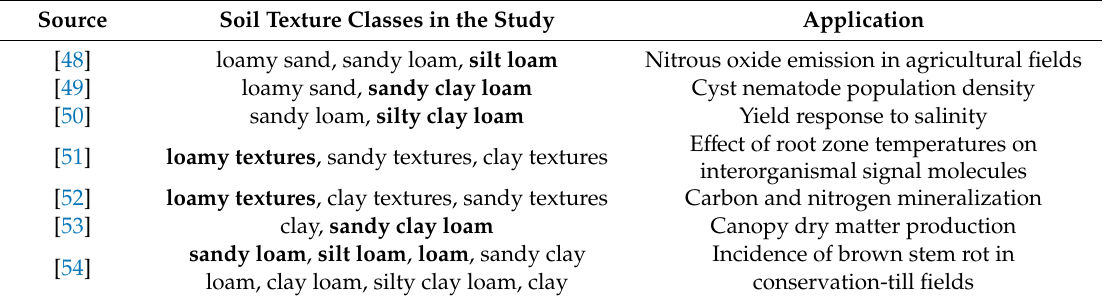
Table 1. Soil texture suitability for various applications from previous soybean-specific studies. Source